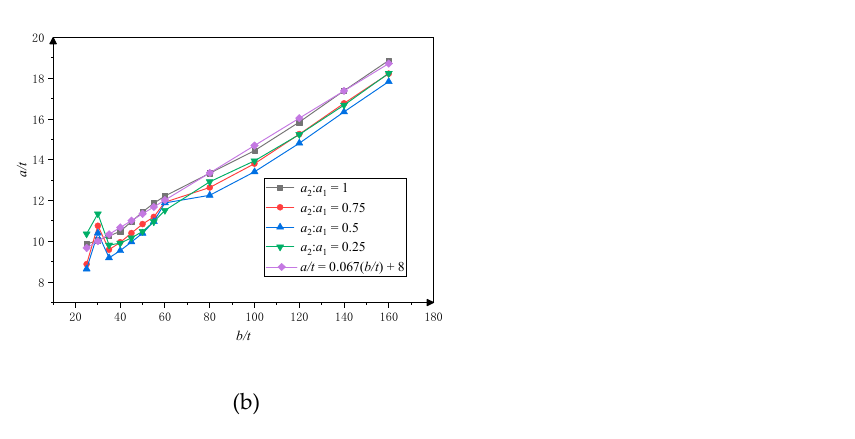
Table 3. Values of a/t when k =